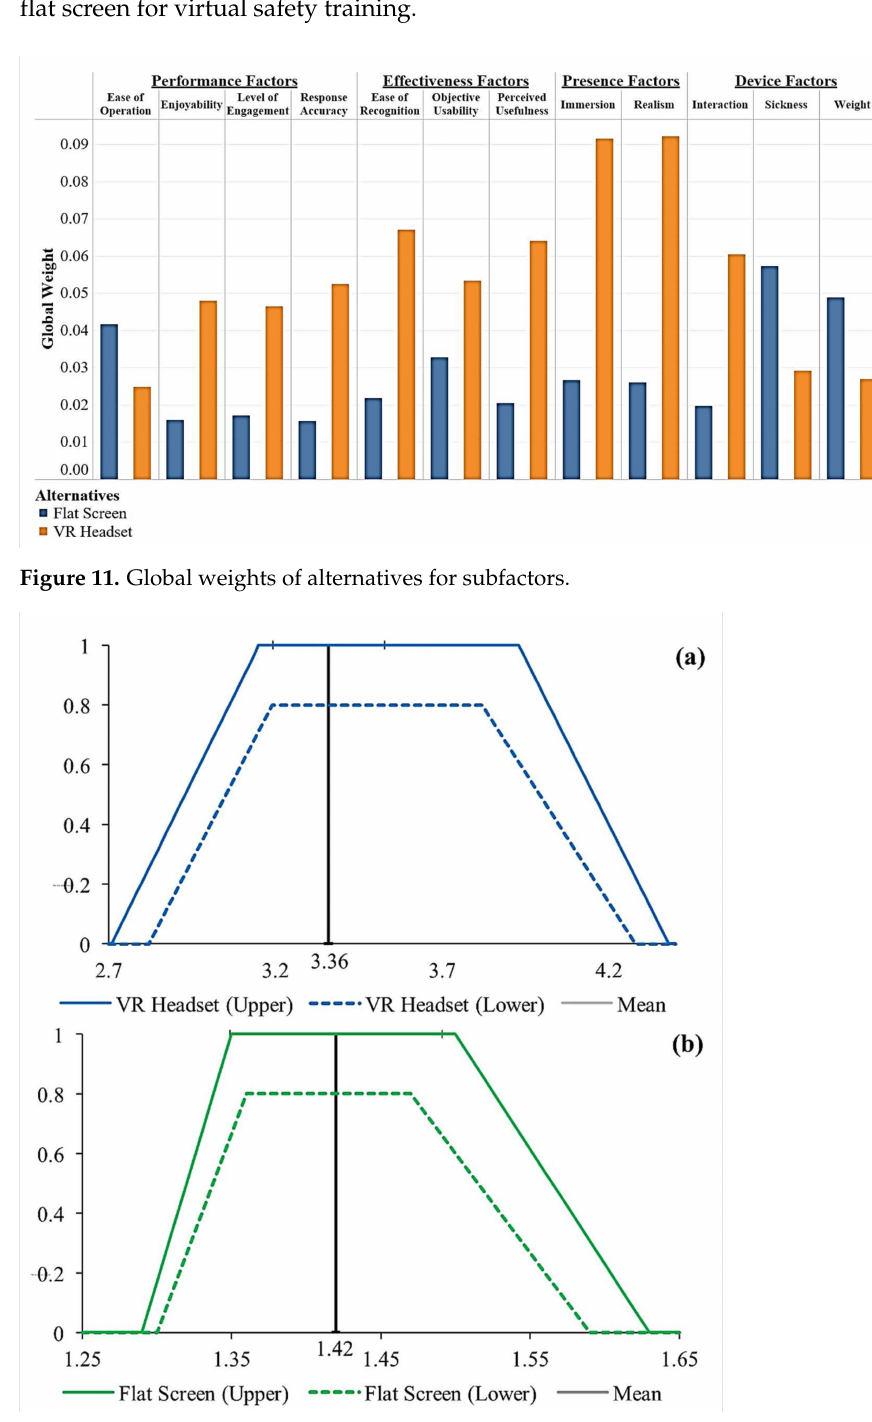
Figure 12. IT2F sets and defuzzied values of ( a ) VR Headset Flat Screen and ( b ) Flat